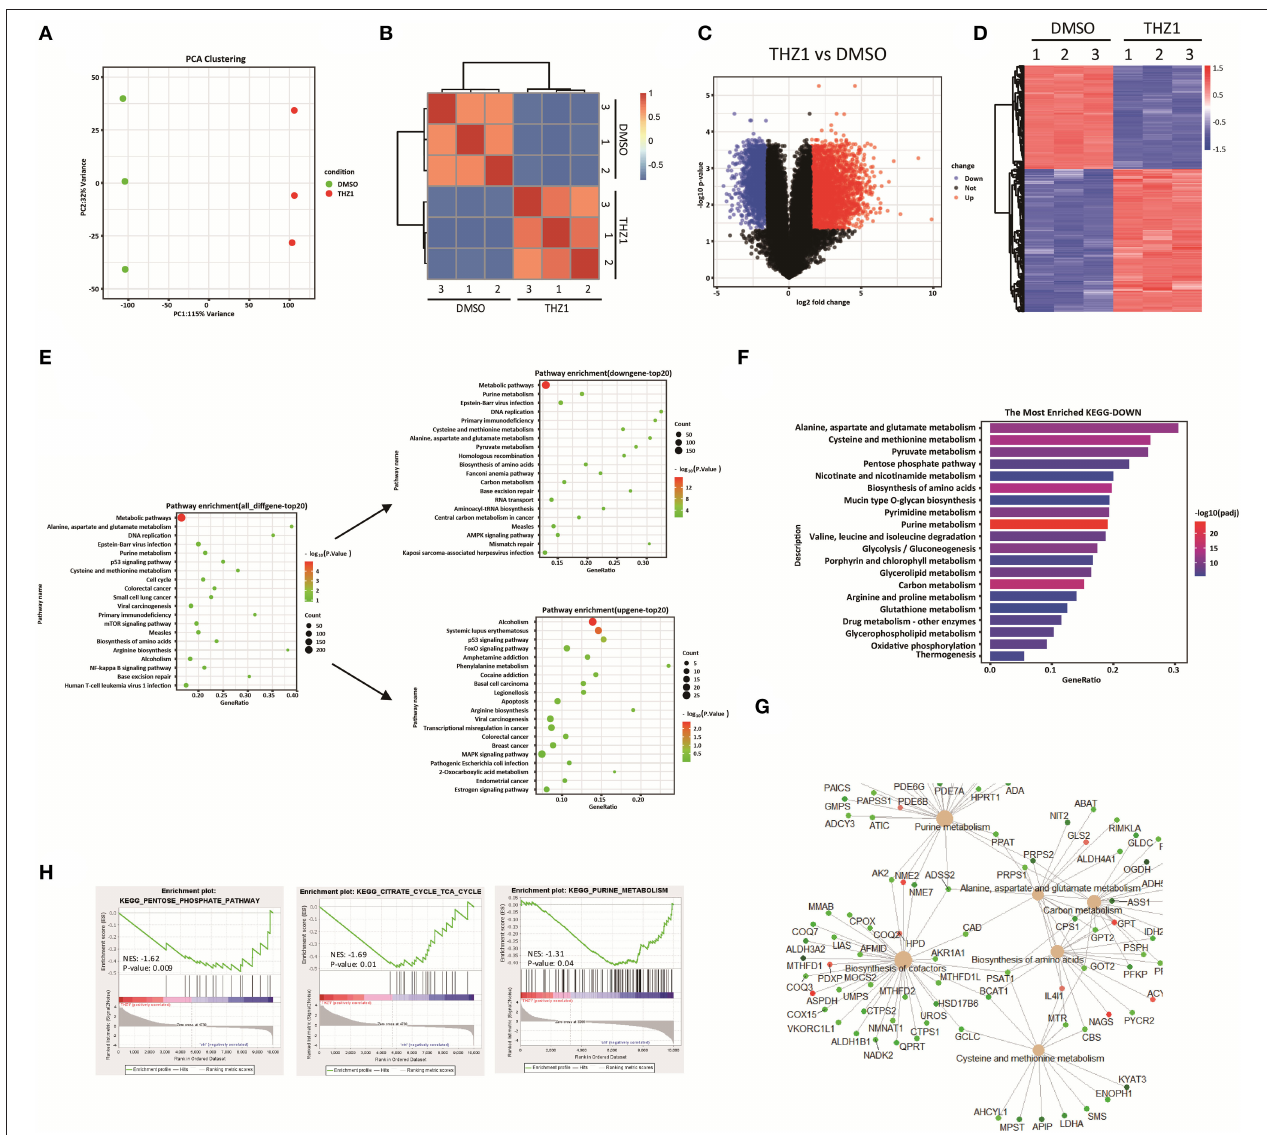
FIGURE 3 | THZ1 perturbs the cellular metabolic pathways of B-ALL cells. (A,B) Principal component analysis and correlation analysis of the RNA-SEQ data in THZ1- and DMSO-treated NALM6 cells. (C,D) Volcano plot and heatmap of differentially expressed genes by a log2-fold change ≥ 1.5 or ≤ − 1.5 ( p < 0.05) in THZ1- and DMSO-treated NALM6 cells. (E) Pathway analysis of upregulated and downregulated genes ( p < 0.05) in THZ1- and DMSO-treated NALM6 cells. (F) KEGG pathway analysis of downregulated metabolic genes ( p < 0.05) in THZ1- and DMSO-treated NALM6 cells. (G) KEGG pathway analysis of downregulated metabolic genes ( p < 0.05) in THZ1- and DMSO-treated NALM6 cells. (H) Gene set enrichment analysis of the genes related to glucose, amino acid, and nucleotide metabolism. B-ALL cells were treated with THZ1 for